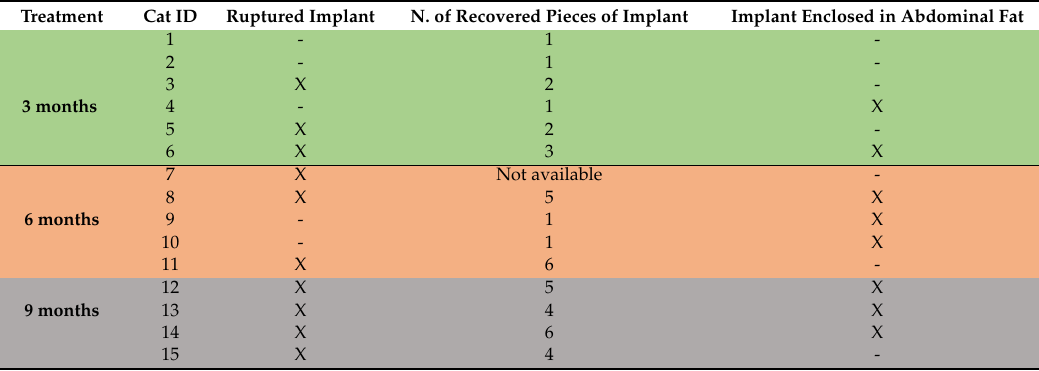
Figure 1. The 4.7 mg deslorelin implants removed surgically from adult tomcats implanted for 3, 6, or 9 months. ( A ) an implant ruptured in four pieces of a cat treated for 6 months; ( B ) comparison between an implant (of a cat treated for 9 months), ruptured and embedded in abdominal fat (left) with an implant of a cat treated for 3 months after surgical removal (right). Table 1. Cat identification, conditions of 4.7 mg deslorelin implants at time of removal, n. of pieces recovered (1 = intact implant) and whether or not implant was enclosed in subcutaneous fat tissue in 15 adult male cats treated with a 4.7 mg deslorelin implant. Implants were removed 3 (green), 6 (orange), or 9 months (grey) following